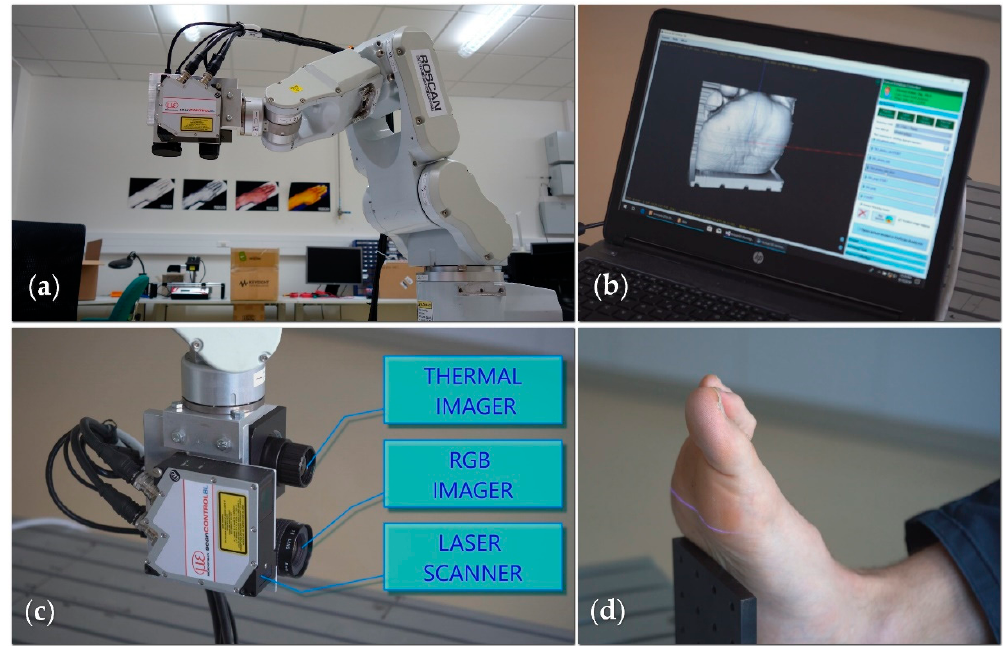
Figure 4. The RoScan system: ( a ) the main hardware components, namely, the robotic manipulator and head with several sensors; ( b ) the software yields a 3D mesh in real time; ( c ) the sensing head comprises a 2D laser scanner, a thermal imager, and an RGB camera; ( d ) the sensing head moves along the body, capturing thousands of distance profiles needed to create a 3D spatial model and taking several images from the thermal and visible spectra; the spectra are then mapped onto the